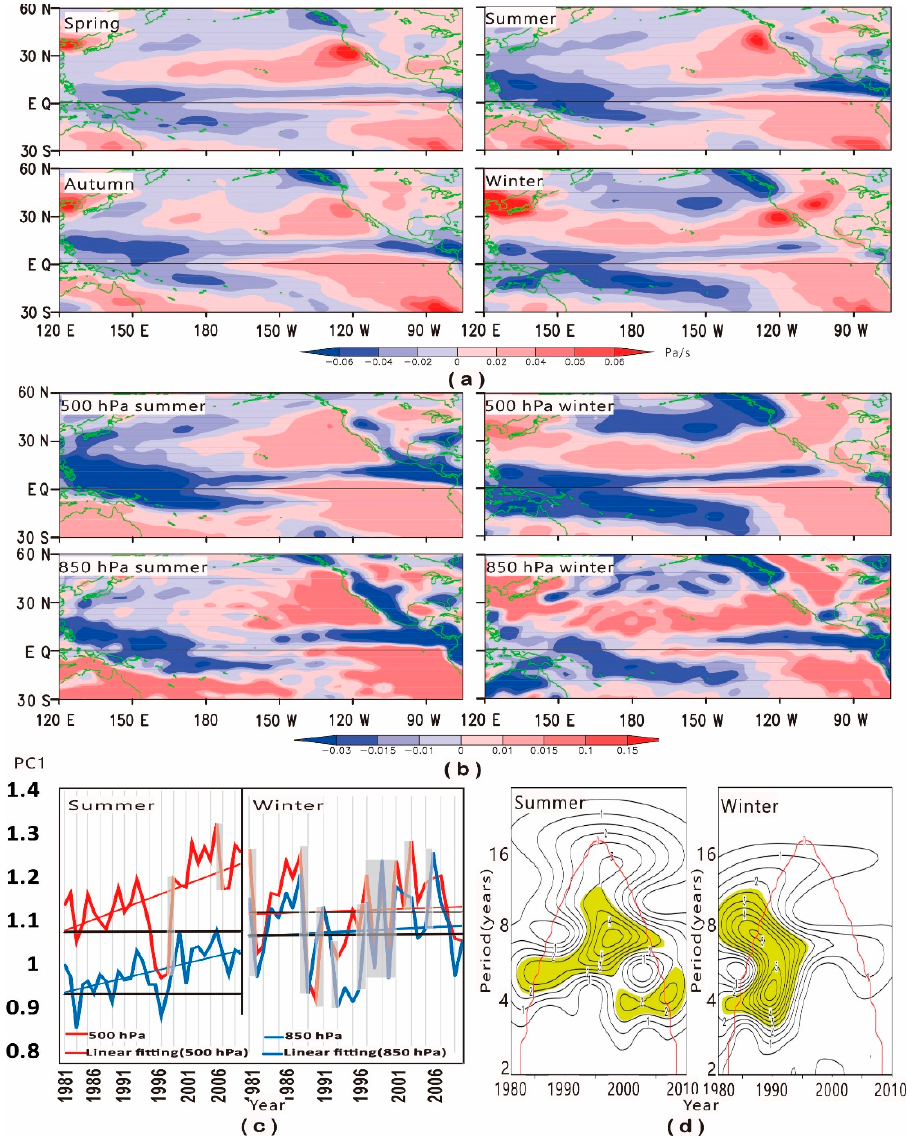
Figure 3. Distribution of the vertical velocity of air over the North Pacific. ( a ) Vertical velocity at winter (December–February). ( b ) Primary EOF-analyzed mode of vertical velocities at 500 and 850 hPa in summer and winter. ( c ) Temporal variation in the primary mode of the vertical velocities at 500 and 850 hPa in summer and winter. PC denotes principal component and gray areas denote large fluctuations. ( d ) Wavelet power spectrum of the temporal coefficients of the primary mode of vertical velocity at 500 hPa in both summer and winter. The red line delineates the cone of influence and the yellow areas show confidence levels >95%.